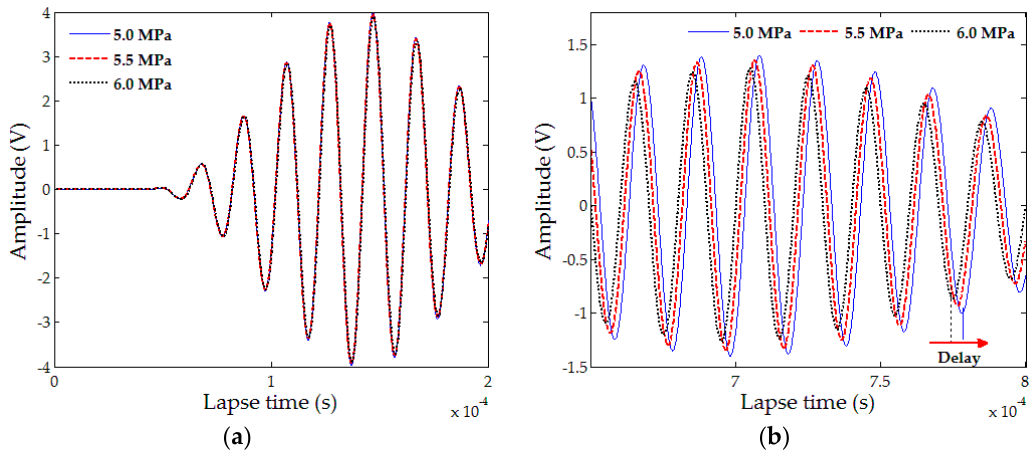
Figure 5. Typical ultrasonic wave signals in concrete: ( a ) earlier parts and ( b ) later parts [58].